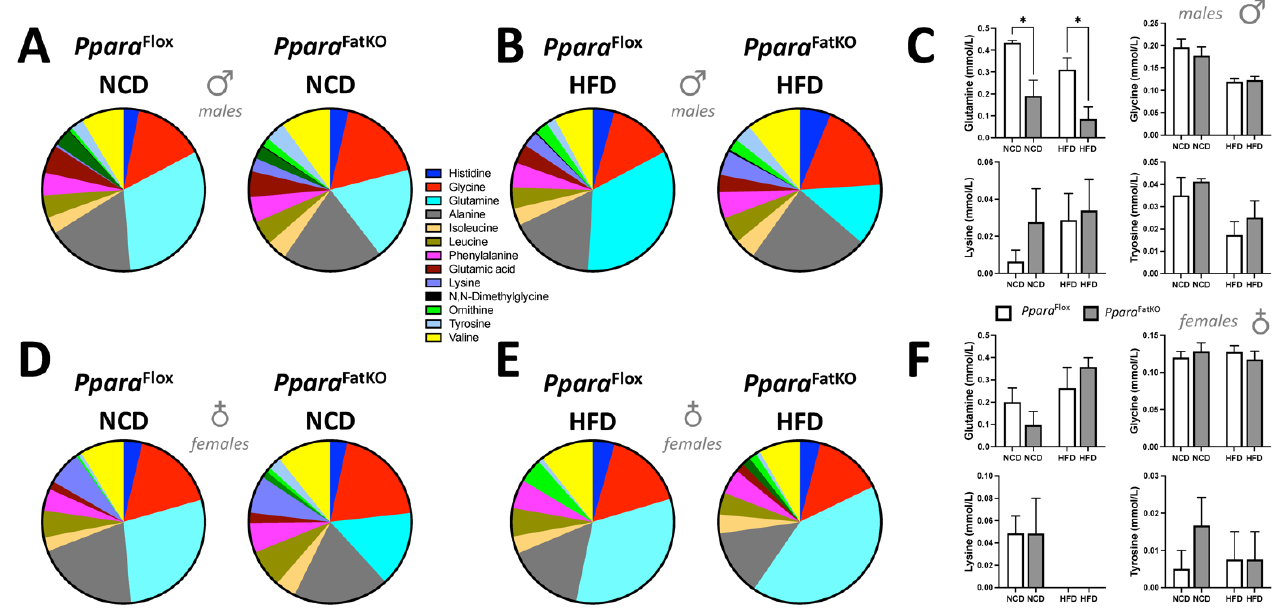
Figure 3. Plasma amino acids in Ppara FatKO and Ppara fl/fl mice fed high-fat or normal-chow diets. Pie and bar graphs of plasma amino acids in male ( A – C ) and female ( D – F ) Ppara FatKO and Ppara fl/fl mice on high-fat (HFD) or normal-chow (NCD) diets. * p < 0.05 (vs. Ppara fl/fl NCD, HFD) (male n = 8 NCD and n = 7 HFD, Ppara fl/fl ; female n = 6 NCD and n = 4 HFD, Ppara fl/fl ; male n = 8 NCD and n = 8 HFD, Ppara HepKO ; female n = 6 NCD and n = 4 HFD, Ppara HepKO ).